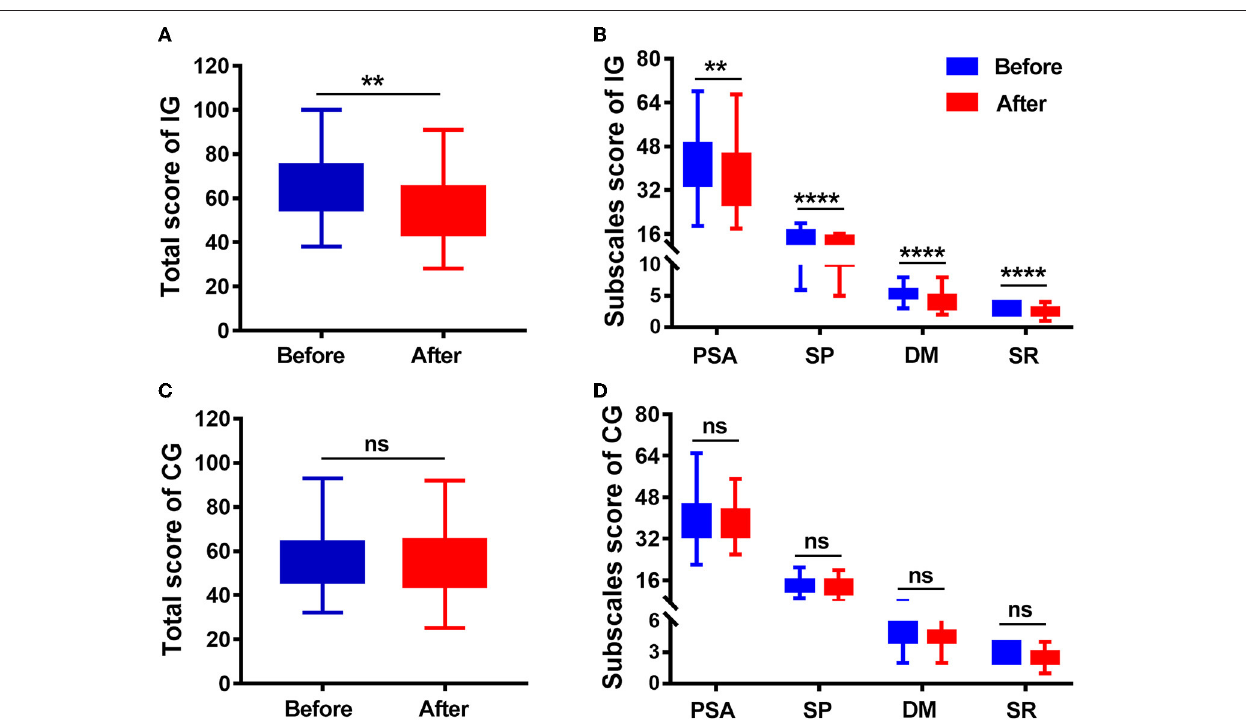
FIGURE 3 | Quality of life (QoL) score at baseline (before) and 4 weeks later (after). (A) Total VLQI-C scores before and after camouflage and psychotherapy in the IG. (B) PSA, SP, DM, and SRS scores before and after camouflage and psychotherapy in the IG. (C) Total VLQI-C scores before and after 4 weeks in the CG. (D) PSA, SP, DM, and SRS scores before and after camouflage and psychotherapy in the CG. IG, intervention group; CG, control group; PSA, psychosomatic and social affect; SP, self perception; DM, disease management; SRS, self-reported severity. ** P < 0.01, **** P < 0.0001, ns,